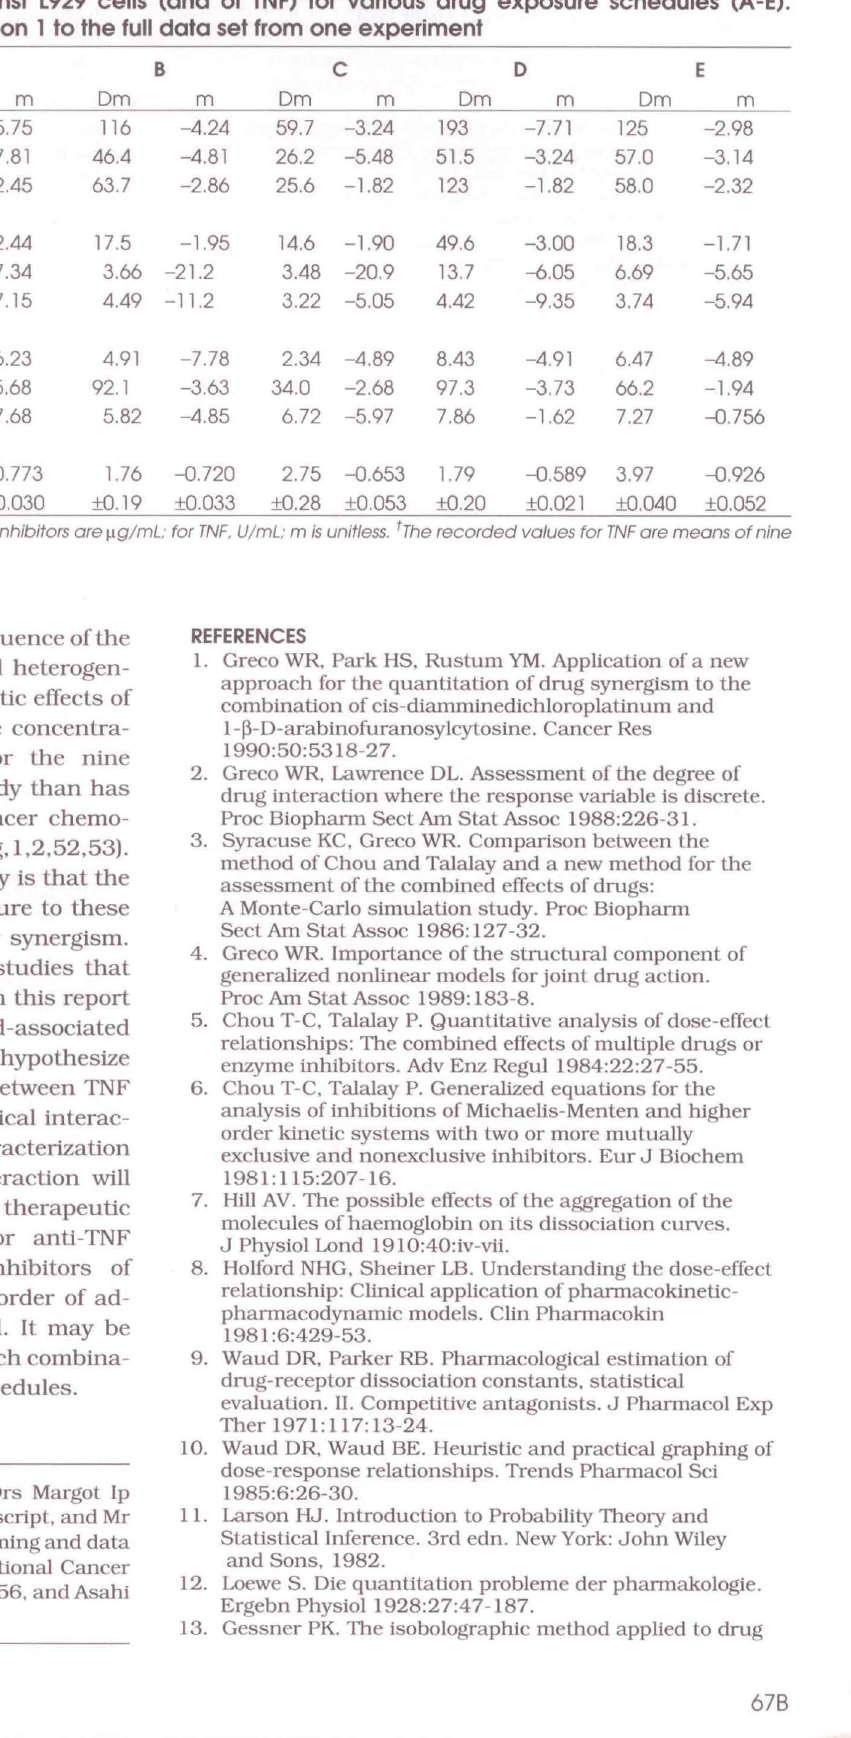
Estimates of Oms (IDsos> and slope parameters (m) for concentration-effect curve of second drug added to tumour necrosis factor (TNF) in combination against L929 cells (and of TNF) for various drug exposure schedules (A-E). Parameters were estimated by fitting Equation 1 to the full data set from one experiment A